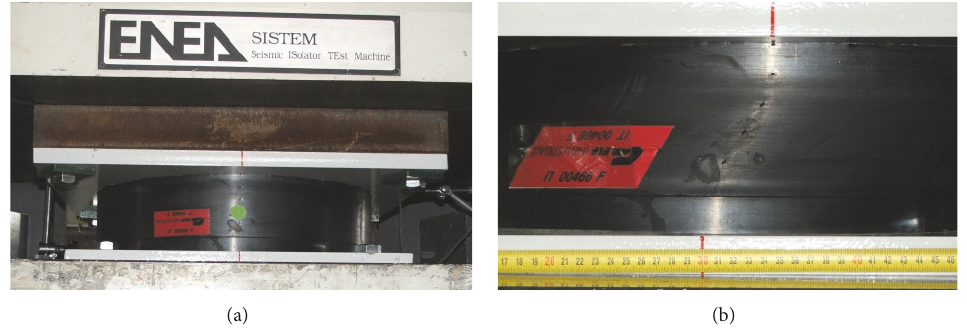
Figure 5: SI-H 500/50 prototype mounted on a roller slide (SISTEM machine)(a) and prototype undergoing 300% shear strain test (courtesy of ENEA) (b).